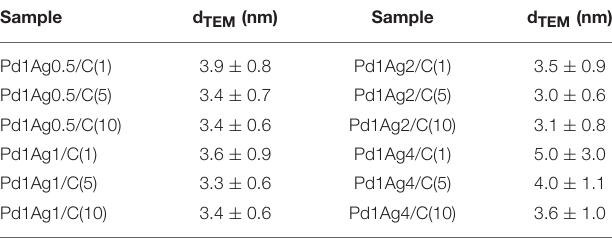
TABLE 3 | Particle size determined by TEM analysis (d TEM ) for all catalysts.